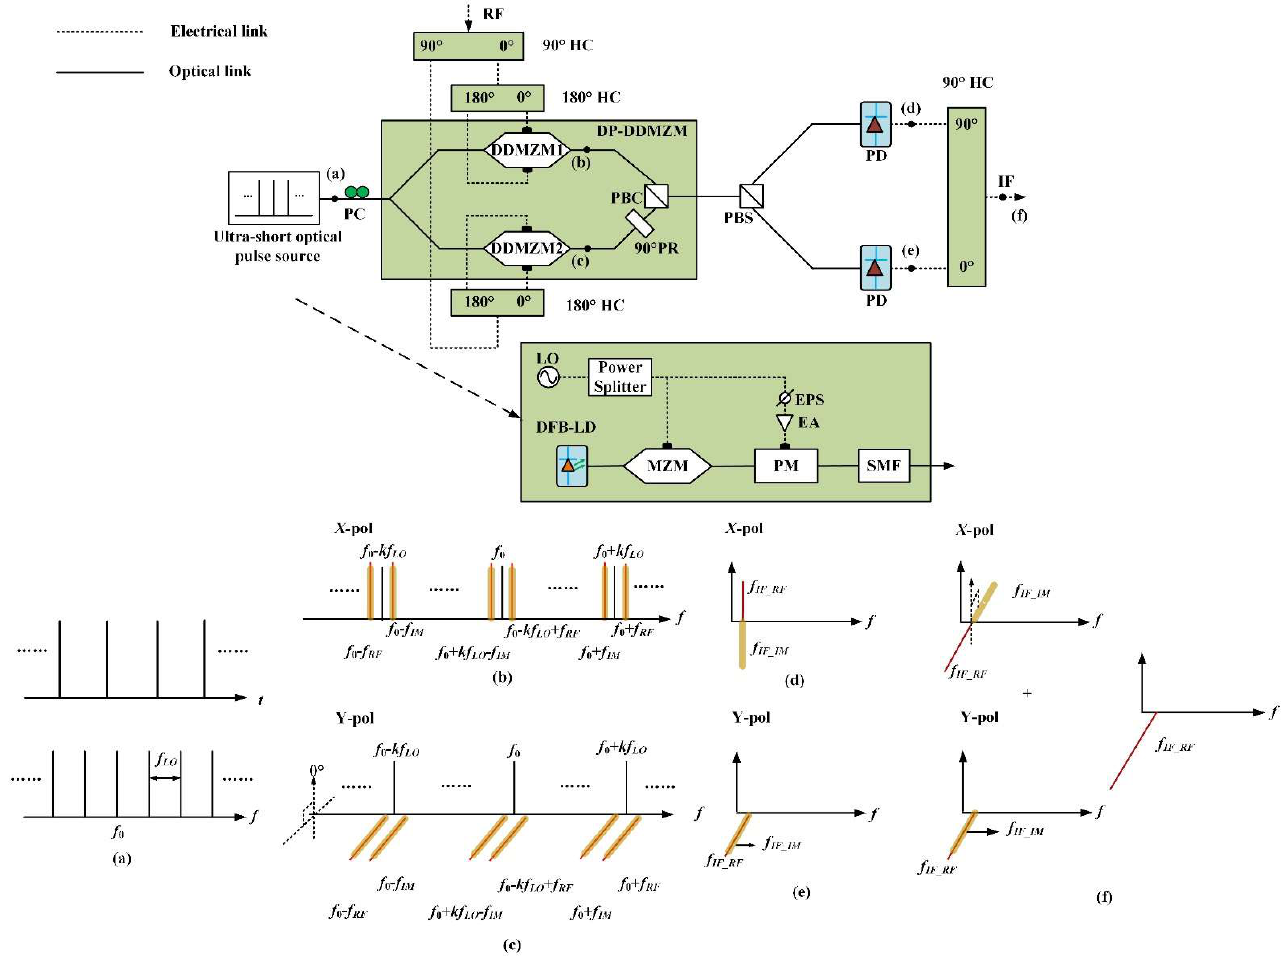
Figure 1. Schematic diagram of the proposed image-rejected multi-band frequency down-conversion. ( a ) Temporal waveform and optical spectrum of the sampling optical pulse train from the cavity-less optical pulse source; ( b ) optical spectrum from DDMZM1; ( c ) optical spectrum from DDMZM2; ( d ) electrical spectrum after photodetection in the upper branch; ( e ) electrical spectrum after photodetection in the lower branch; ( f ) electrical spectrum after quadrature coupling. PC: polarization controller; RF: radio-frequency; DP-DDMZM: dual-polarization dual-drive Mach–Zehnder modulator; 90° PR: 90° polarization rotator; PBC: polarization beam combiner; PBS: polarization beam splitter; PD: photodetector; HC: hybrid coupler; DFB-LD: distributed-feedback laser diode; MZM: Mach–Zehnder modulator; PM: phase modulator; SMF: single-mode fiber; LO: local oscillator; EPS: electrical phase shifter; EA: electrical amplifier. gle-tone microwave signals of V LO 1 ( t ) = V LO 1 ·cos( ω LO t ) and V LO 2 ( t ) = V LO 2 ·cos( ω LO t ), respec-